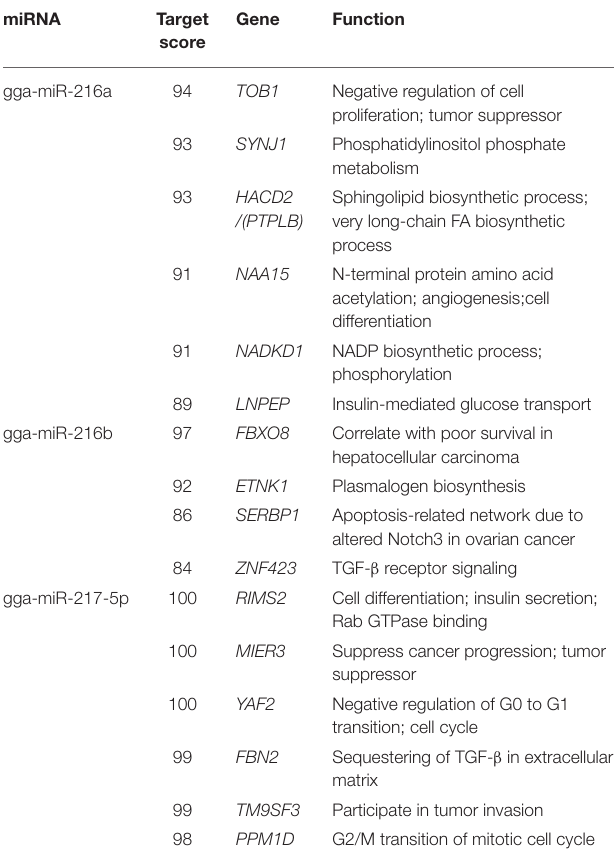
TABLE 1 | Potential targets of the miR-216/217 cluster.